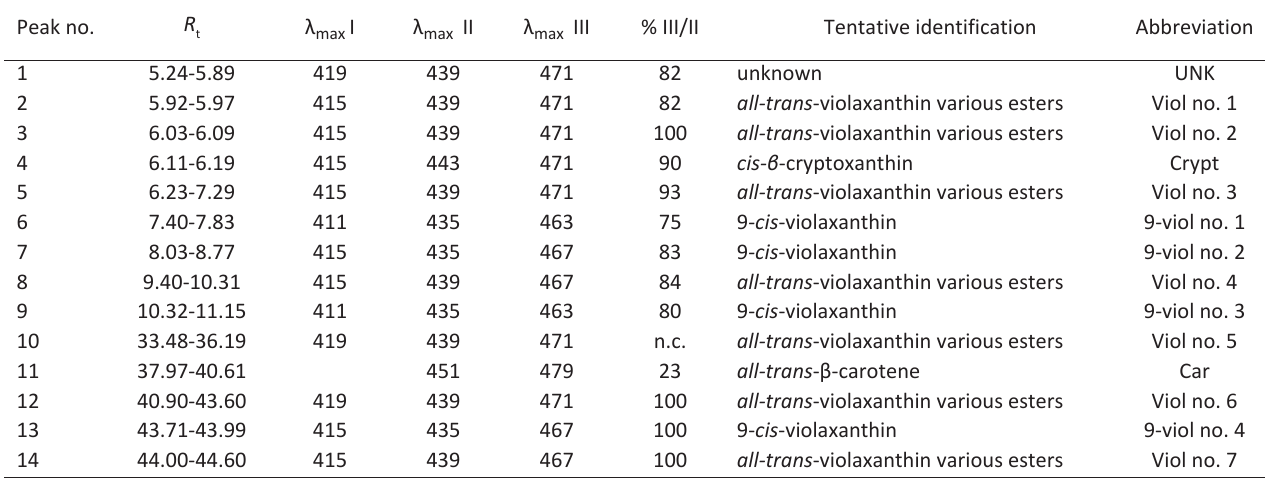
Table 1 - Retention time (Rt, min), spectra characteristics [λ max (nm) in the mobile phase, obtained by DAD, spectral fine structure (% III/II)] and name abbreviation of tentatively identified compounds according to Ornelas-Paz et al. (2007, 2008) Peak